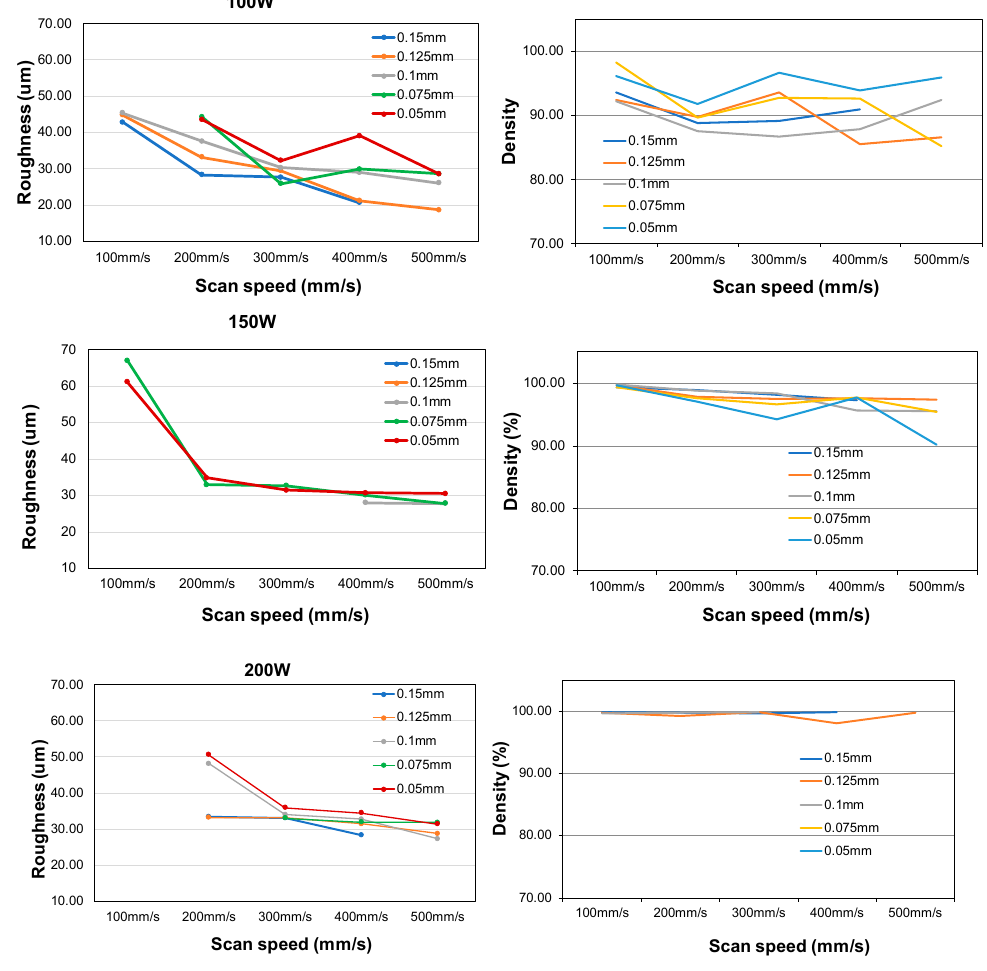
Figure 3. Top surface roughness (left column) and density measurement (right column) of mixed B 4 C (20 wt%) and AlSi10Mg (80 wt%).